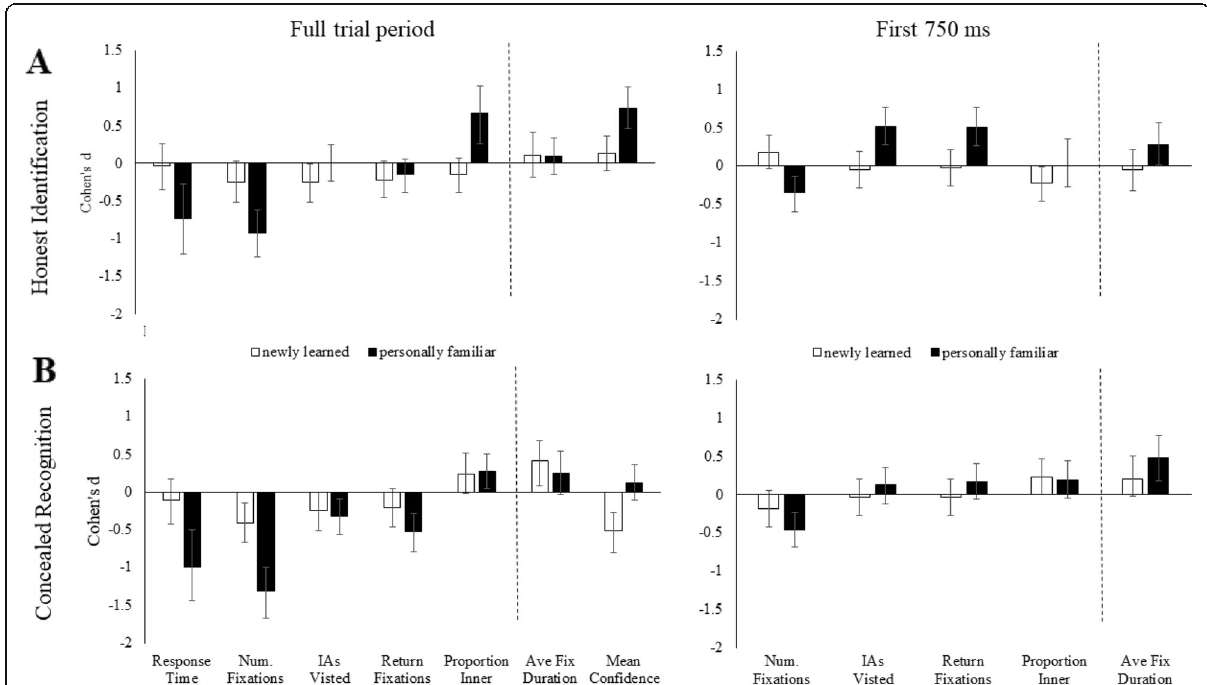
Fig. 4 Cohen ’ s d effect size differences (95% CIs) for non-face items in Experiment 2 a honest identification of familiar non-face items compared to unfamiliar non-face items, b concealed recognition of familiar non-face items compared to unfamiliar non-face items. On the left , data shown for the Full trial period are Response Times, Num. Fixations, IAs Visited, Return Fixations, Proportion Inner, Ave Fix Duration, Mean Confidence. On the right , we show re-analysis of the five fixation markers for the First 750 ms of the trial: Num. Fixations, IAs Visited, Return Fixations, Proportion Inner, Ave Fix Duration. Cohen ’ s d effect sizes are shown for comparisons between personally familiar non-face items and unfamiliar non-face items ( black bars ) and newly learned non-face items compared to unfamiliar non-face items ( white bars ). Tests of equality for effect sizes between honest and concealed conditions are presented in Supplementary Material Table